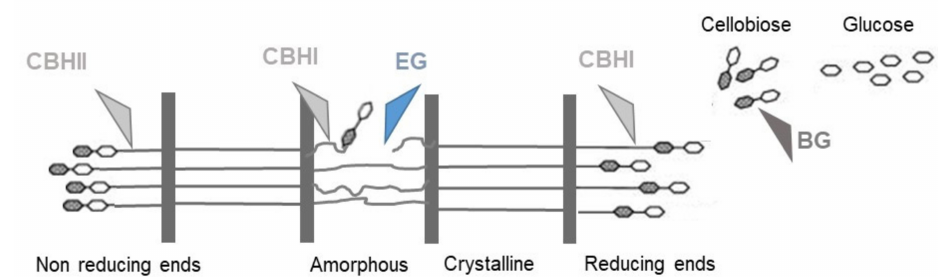
Figure 9. Mechanism of action of cellulase on cellulose. CBH, cellobiohydrolase; EG, endoglucanase; BG, β -glucosidase.